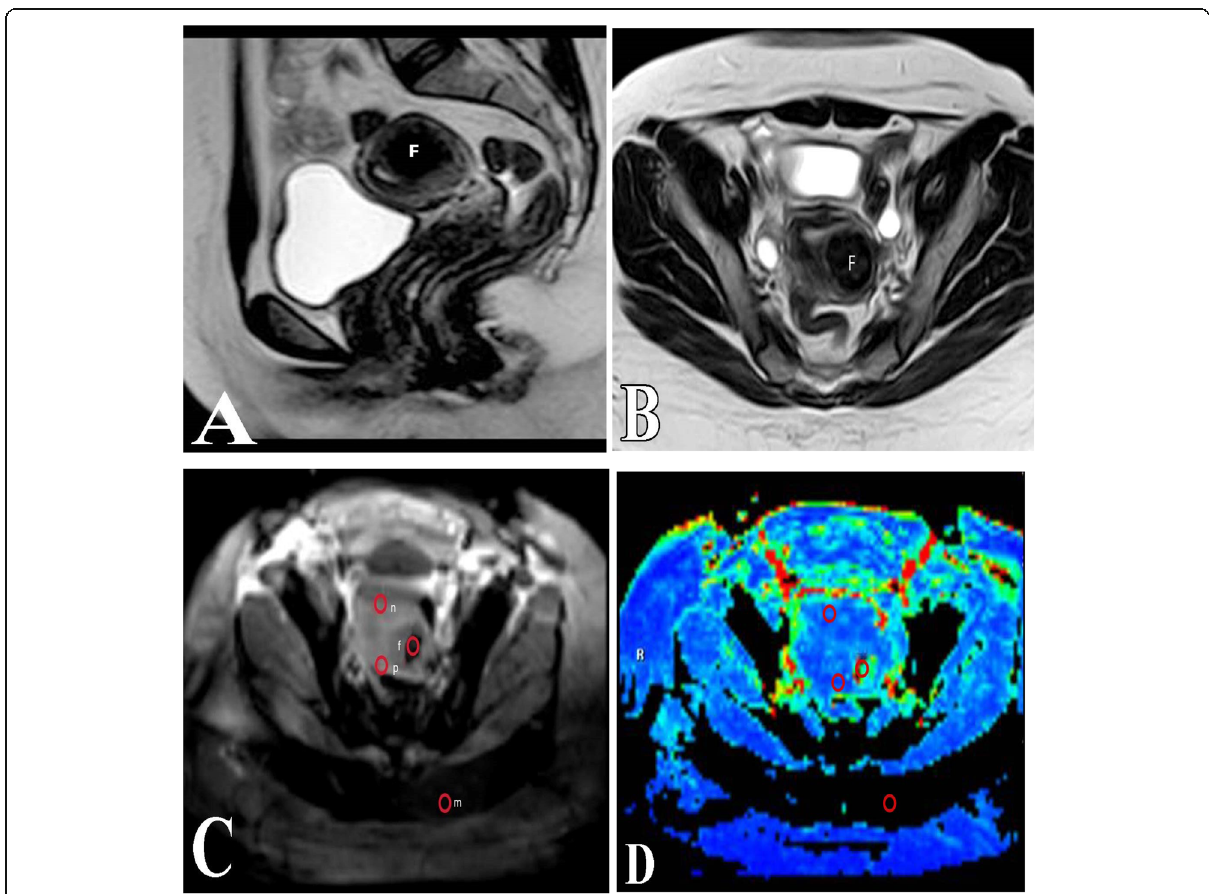
Fig. 3 Fertile female patient aged 44 years old. a , b Sagittal and axial T2WI of the uterus showing posterior wall submucous fibroid [F] with low T2 SI measuring about 3 × 3.5 × 3 cm (ApxTrxHt). c ASL gray scale map and d ASL color map with the ROIs placed in the anterior uterine wall (negative wall:n), posterior uterine wall (positive wall: p), fibroid (f), and the gluteus maximus muscle (m). In this case, the perfusion of the positive wall was 486, of the negative wall was 647, and of the fibroid was 476 denoting that the perfusion was lower in the positive wall than the negative wall and the perfusion of the fibroid was less than both positive and negative uterine